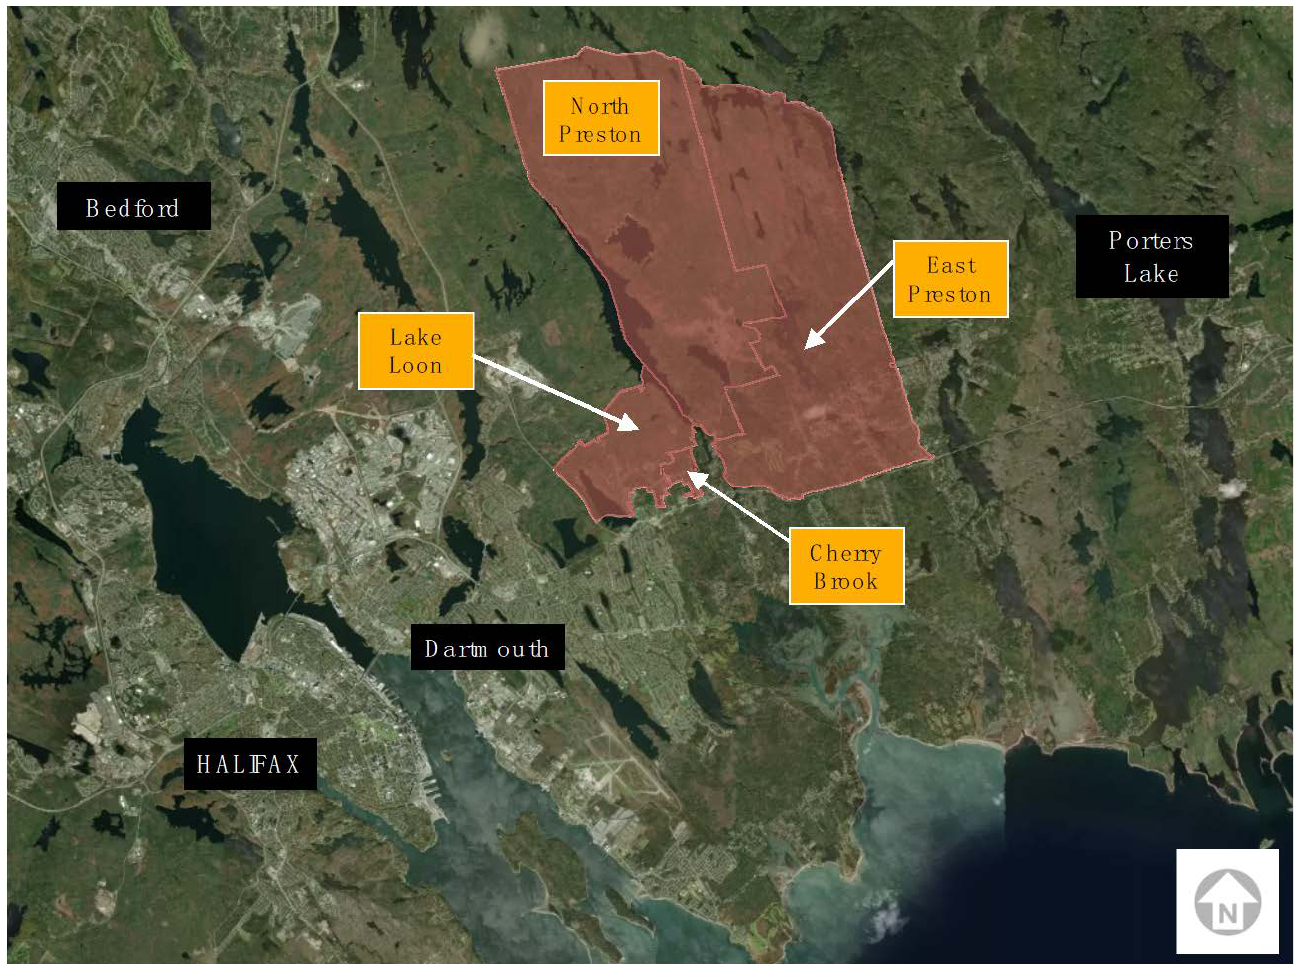
Figure 2. Regional map of the study area’s four communities: North Preston, East Preston, Cherry Brook, and Lake Loon.